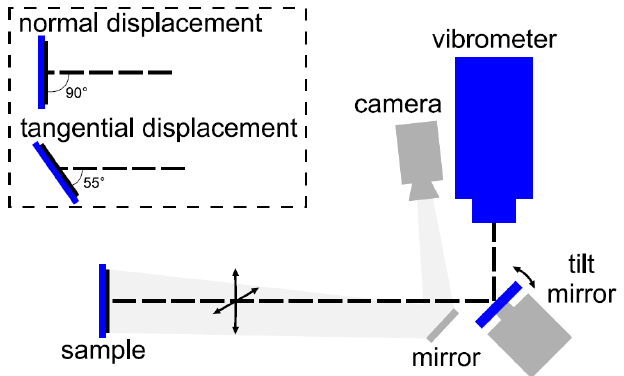
Figure A3. Sketch of the setup used to determine both the normal and the transverse component of the displacement from LDV.